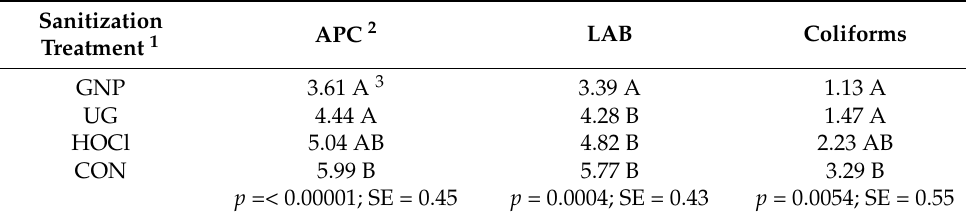
Table 3. Least squares means of surviving aerobic bacteria, lactic acid bacteria, and coliforms following sanitization treatment application on non-inoculated tomato skin samples.